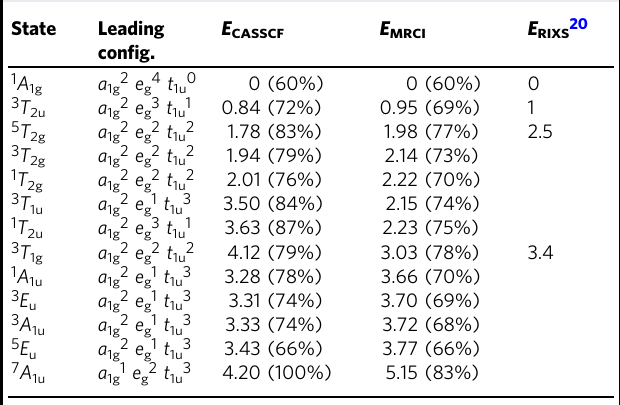
Weights of leading con fi gurations are provided within brackets. Computational results based on complete active space self-consistent fi eld (CASSCF) and more sophisticated multi-reference con fi guration interaction (MRCI) are given in comparison to experimental resonant inelastic x-ray scattering (RIXS)